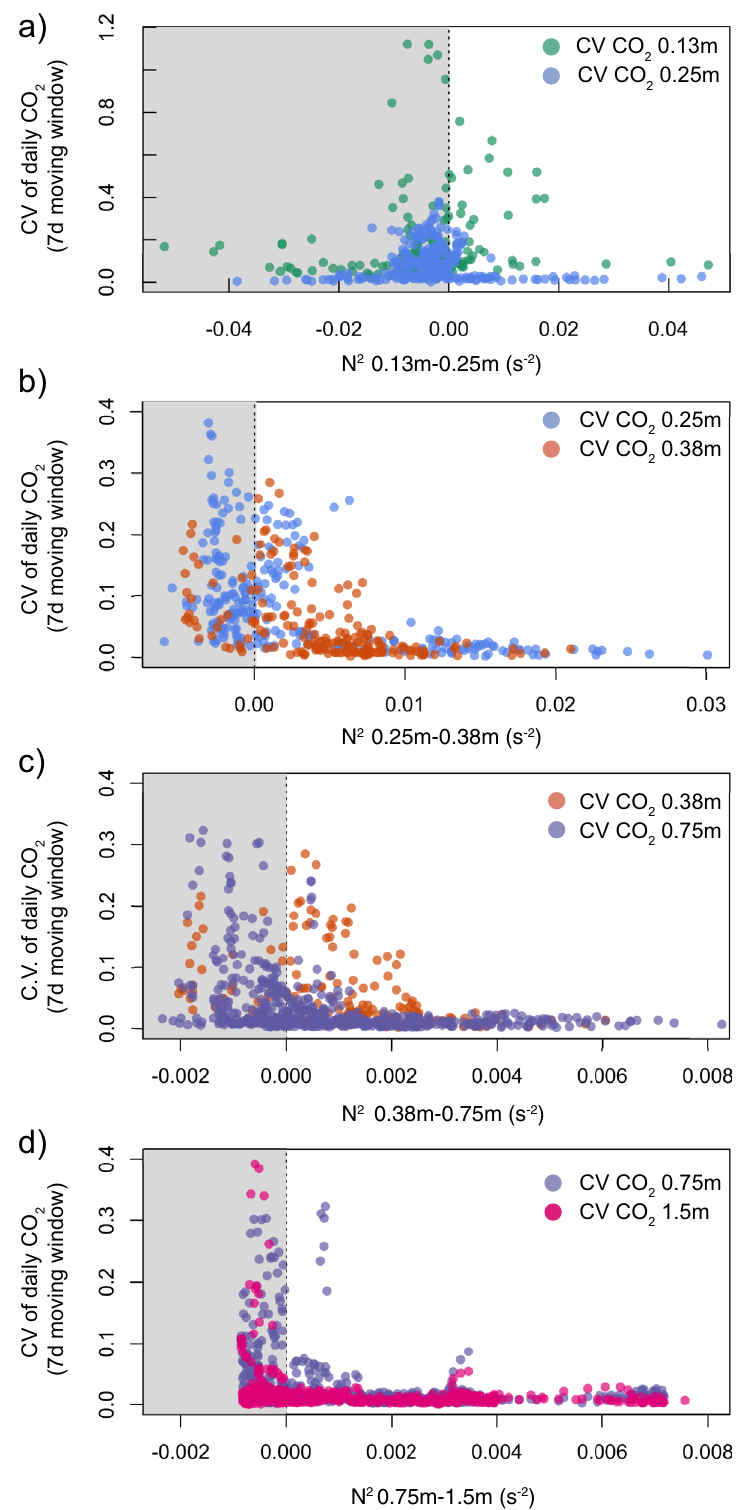
Fig. 2 Relationship between porewater CO 2 concentration variability and thermal stability. The 7-day moving coef fi cient of variation (C.V) for the daily averaged porewater CO 2 concentration plotted against the daily averaged buoyancy frequency (N 2 ) between different pairs of adjacent porewater depths: in a 0.13 and 0.25 m, b 0.25 and 0.38 m, c 0.38 and 0.75 m, d 0.75 and 1.5